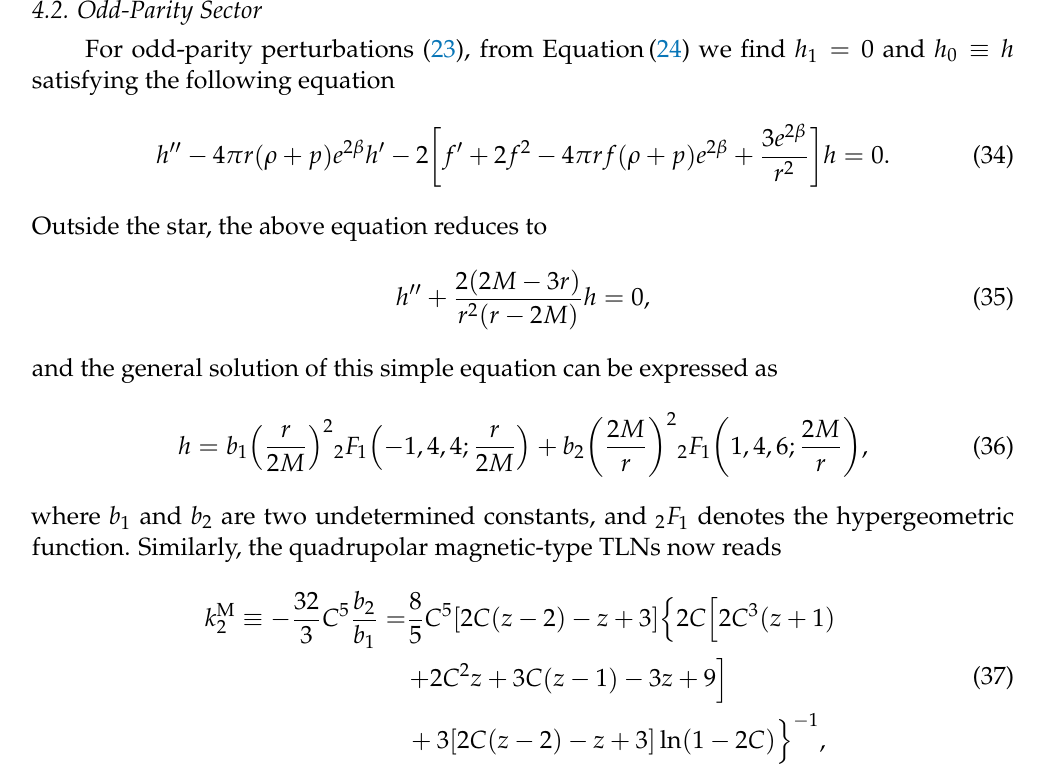
Figure 1. The relationship between dimensionless tidal deformability and the mass of a star with adiabatic index Γ = 2 for different values of dimensionless non-conservation parameter ˜ k . As a comparison, the constraints from gravitational wave observations on the star are presented. The blue shaded box is drawn based on the 90% confidence upper bound and the 90% confidence interval on the masses of the observed neutron stars from observations given by GW170817. Meanwhile, the green and red boxes represent the same bounds for the primary and secondary components with the low-spin priors in GW190425,